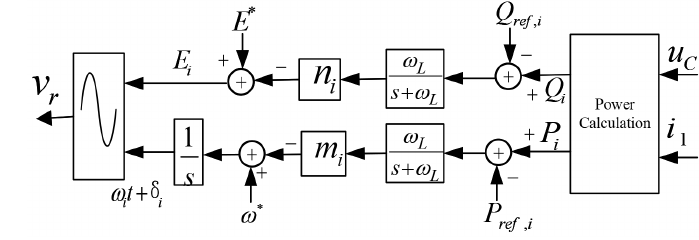
Figure 2. Conventional droop control.